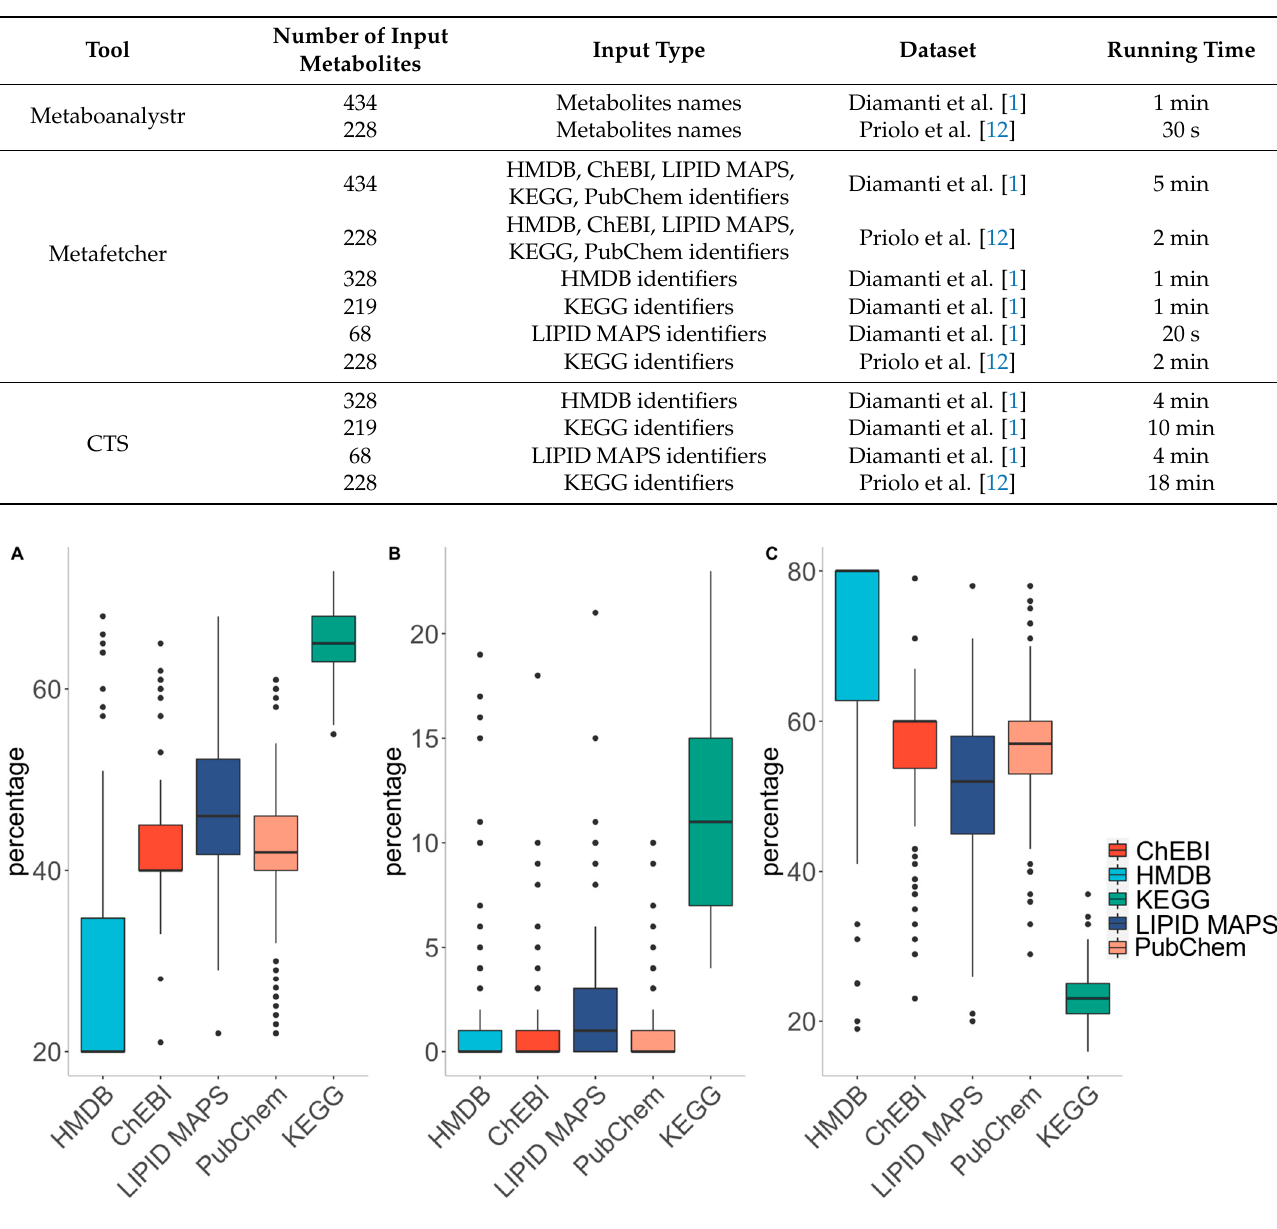
Figure 4. The results for the test that was run on each database to investigate data quality. ( A ) Box plot for the fraction of successfully mapped identifiers that had one-to-one mappings to the rest of the database metabolite identifiers after running the test 100 times for each database. ( B ) Box plot for the fraction of successfully mapped identifiers that had at least one one-to-many mappings to the rest of the database metabolite identifiers after running the test 100 times for each database. ( C ) Box plot for the extent of unmapped identifiers to the rest of the database metabolite identifiers after running the test 100 times for each